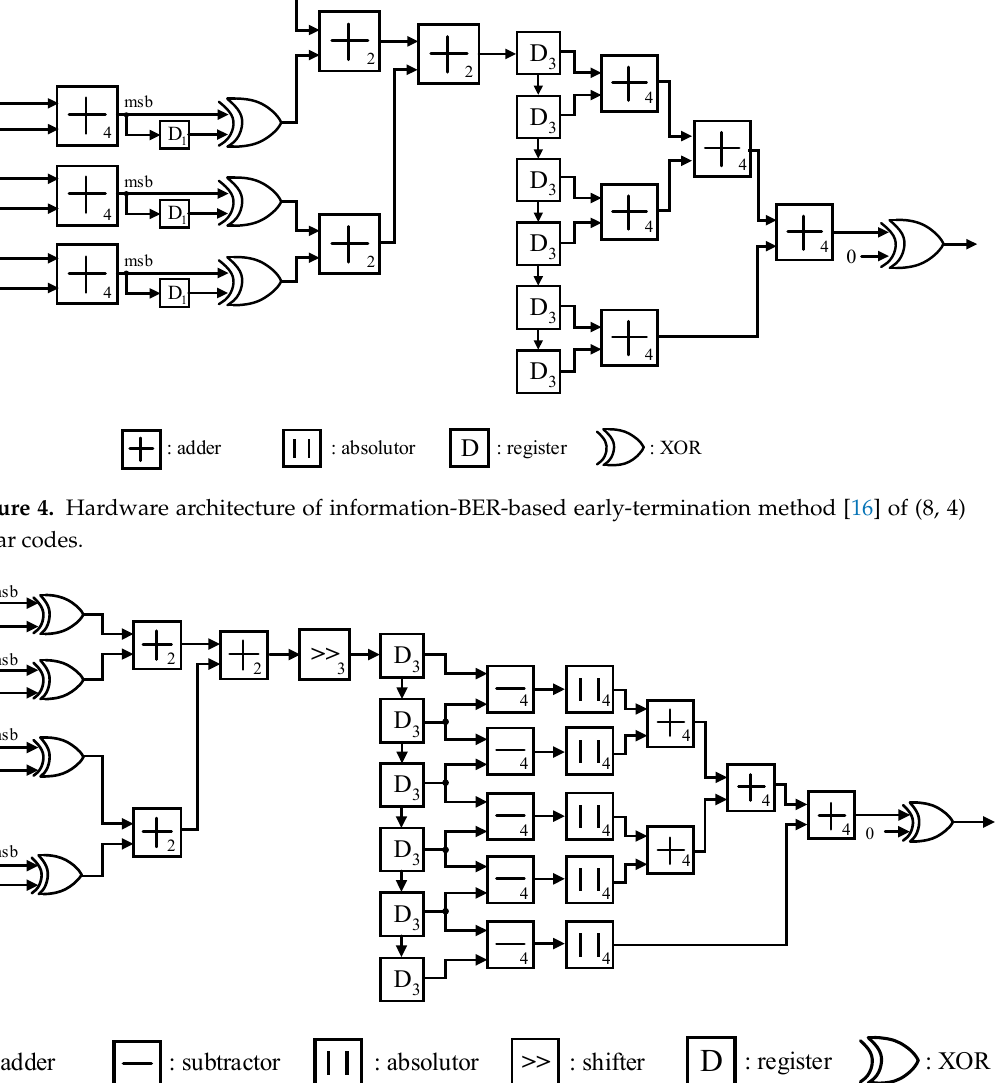
Algorithm 3: Frozen-BER-based [17] early-termination technique